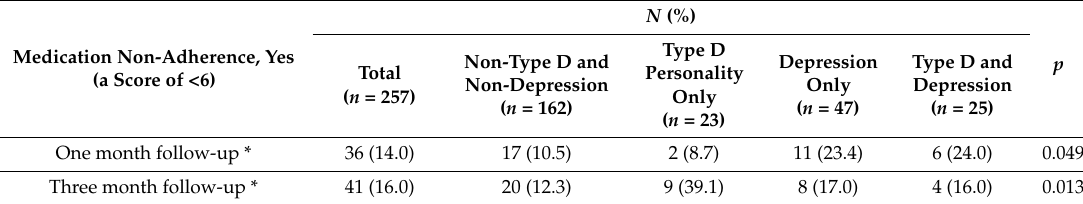
Table 2. Frequency of medication non-adherence by Type D personality and depression groups at baseline. Medication Non-Adherence, Yes